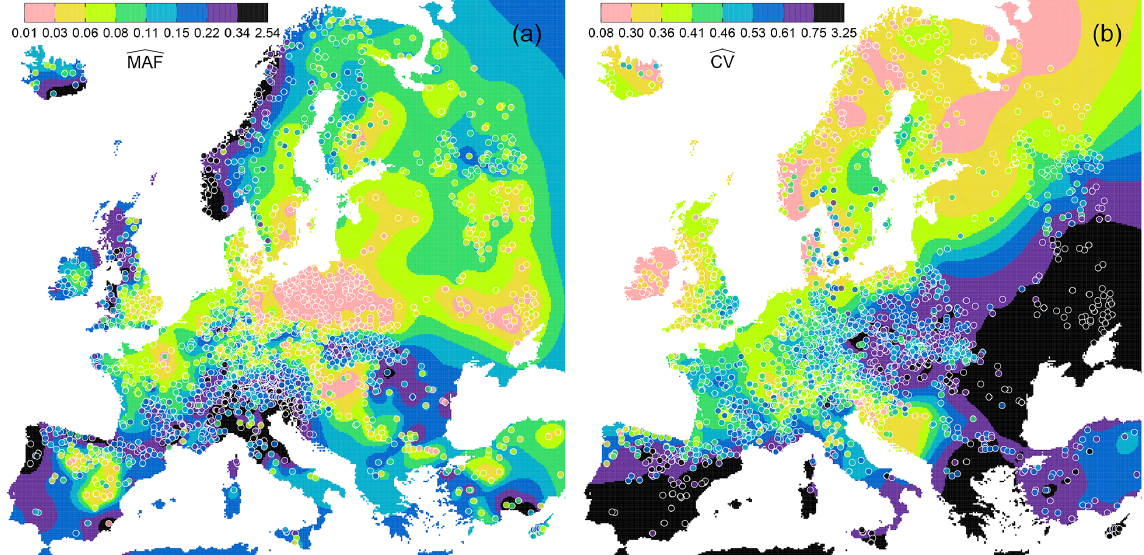
Figure 10. Predicted values of regional regression models and ordinary kriging for MAF (m 3 s − 1 km − 2 ) and CV. Circles refer to predictions of regression models, and background refers to predictions of kriging. Colours refer to binned classes of equal frequency for original data (estimated statistical moments) as in Fig.